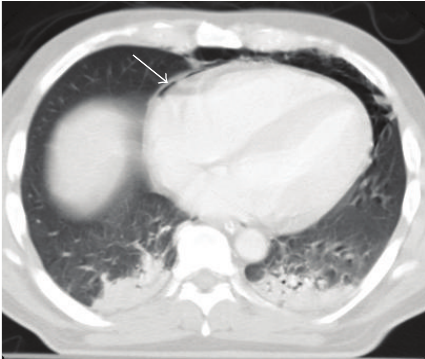
Figure 9: Right hemothorax with the “hematocrit sign.” Postcon- trast axial MDCT at the level of ventricular chambers demonstrates a right pleural effusion with a liquid-liquid level (curved arrow), giv- ing an aspect of layered effusion, consistent with right hemothorax with different degrees of blood coagulation (“hematocrit sign”).